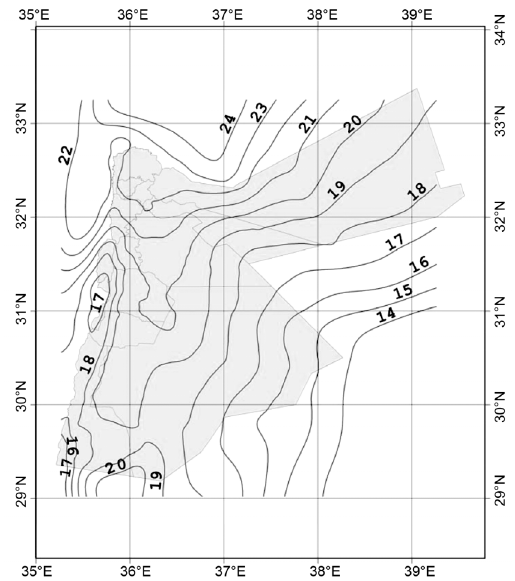
Fig. 4. The Gravimetric Jordanian-Geoid-Model «GeoJordan» (latitude and longitude in WGS84 and geoidal undulation in m).